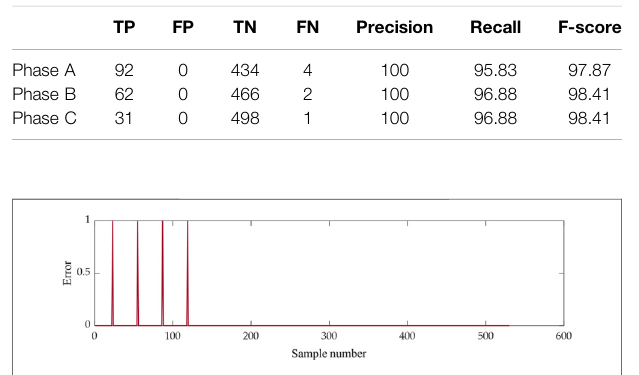
TABLE 3 | Accuracy of fault detection using SVM-based model.